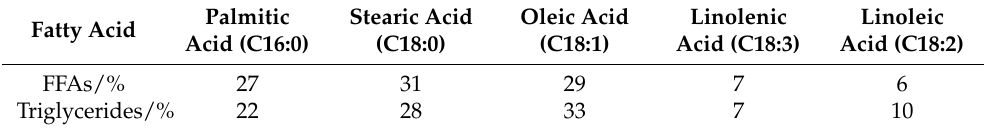
Table 5. The fatty acid content in cooking